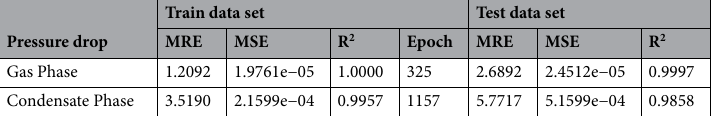
Table1. The optimal values of MRE, MSE, R2 and epoch for training and test data sets.